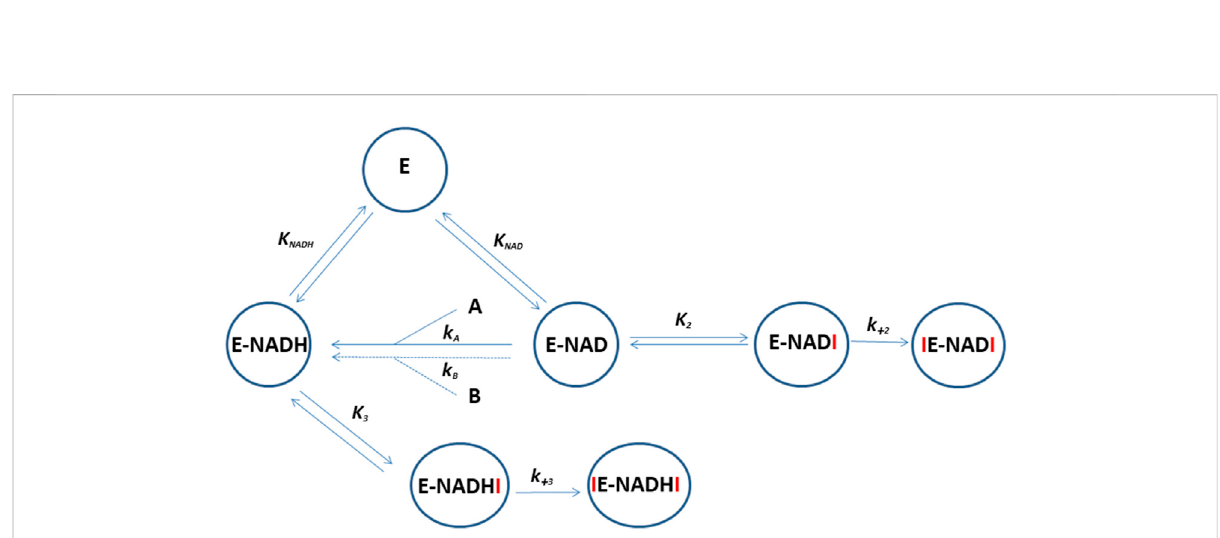
Reaction scheme for the oxidation of 1-acenaphtenol by AKR1C1-3 and its inhibition by ruthenium compounds. E represents apoenzyme, E-NAD and E-NADH represent holoenzyme with bound NAD + and NADH, respectively. A and B are enantiomers of substrate 1-acenaphtenol. Symbols which include I (ruthenium compound) represent holoenzyme in complex with one or two inhibitor molecules. K NAD , K NADH , and K 2-3 are equilibrium constants and k +2 – 3 are second-order association rate constants for the binding of the second inhibitor molecule to the enzyme. The progress curves for each enzyme in the presence of ruthenium complexes were analyzed by the WEB server ENZO (https://enzo.cmm.ki.si/) designed exactly for such purposes (Bevc et al.,